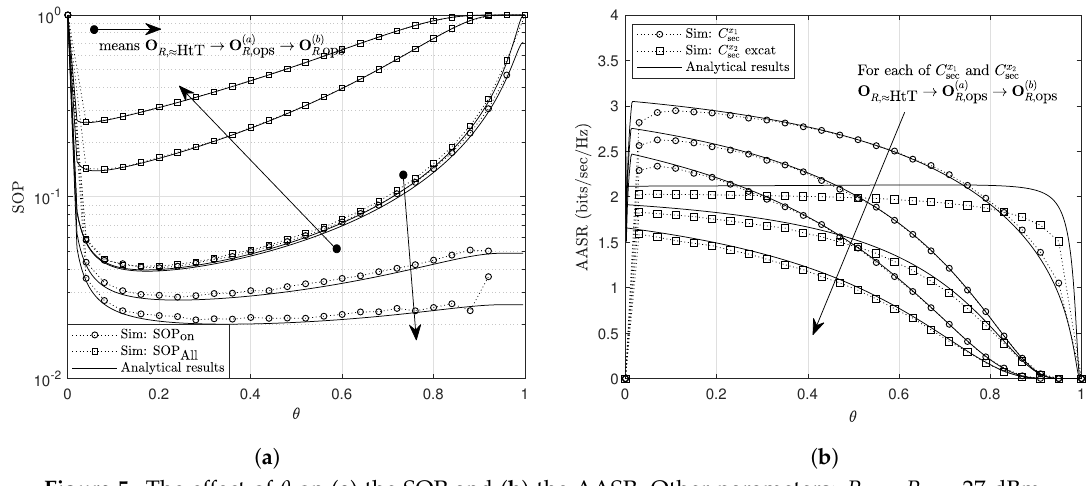
Figure 5. The effect of θ on ( a ) the SOP and ( b ) the AASR. Other parameters: P a 1 = b 1 = 0.1, ( R x 1